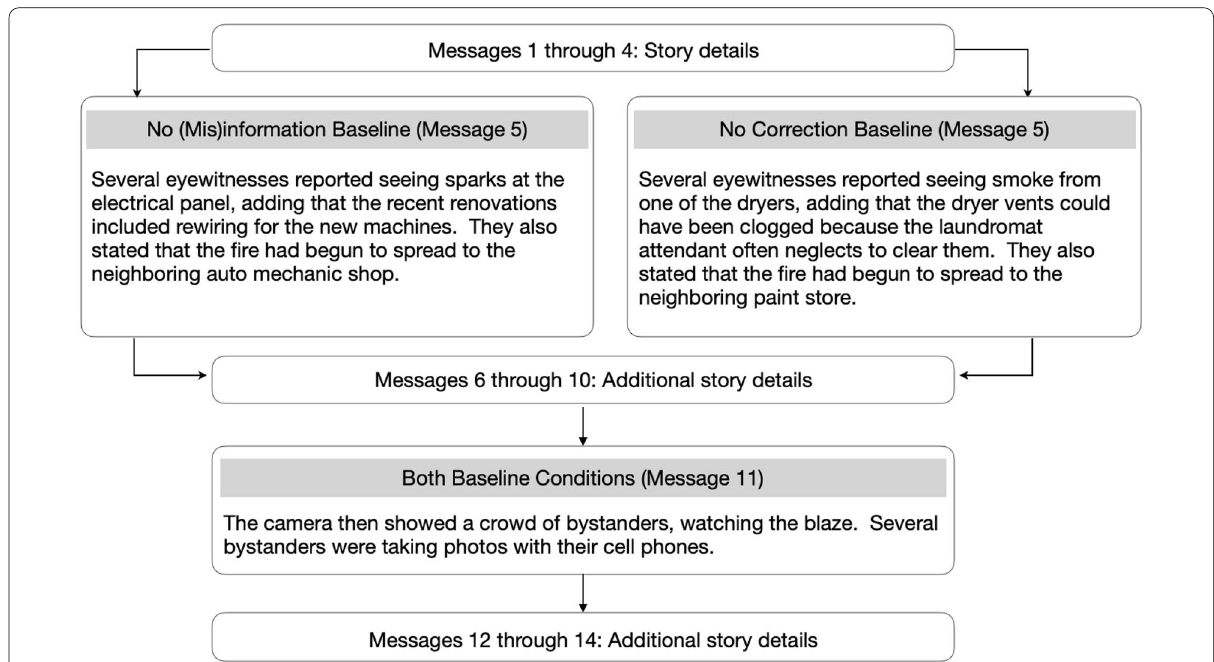
Fig. 6 Summary of message sequence and additional details for baseline conditions in Experiment